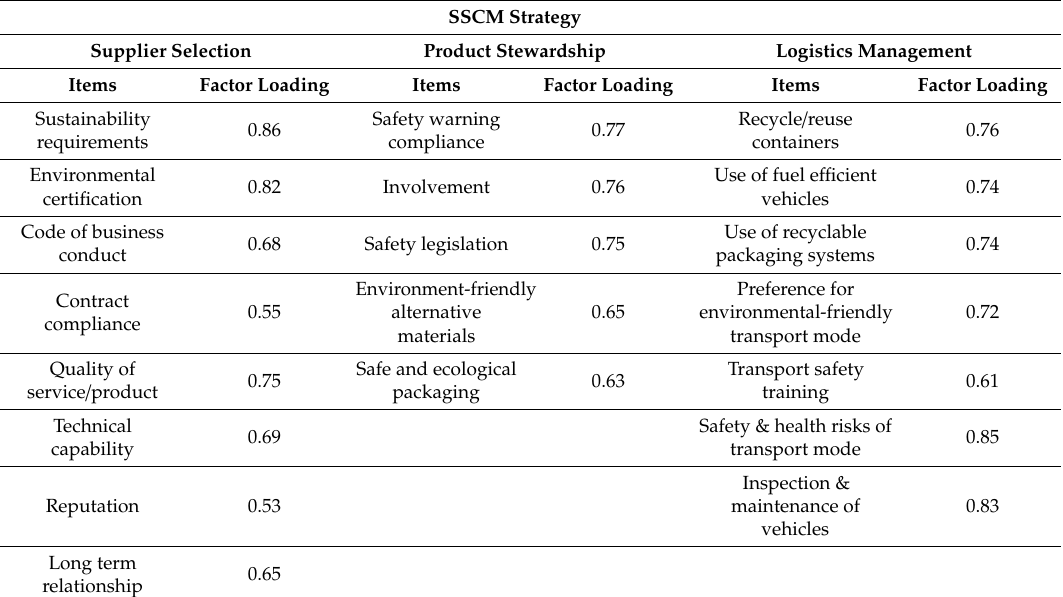
Table 9. Results of Exploratory Factor Analysis (EFA) for Sustainable Supply Chain Management (SSCM) strategies.